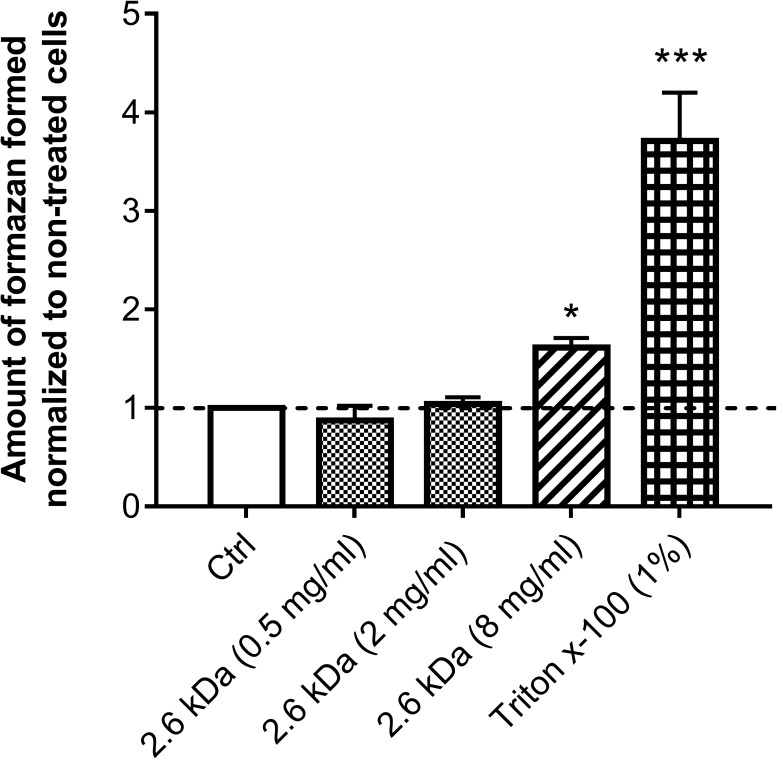
Effect of the 2.6 kDa chitosan on LDH release from MAC-T bovine mammary epithelial cells.Cells were exposed to the 2.6 kDa chitosan at different concentrations (0.5 mg/ml, 2 mg/ml and 8 mg/ml). Triton x-100 and culture medium were used as cytotoxic positive and negative (Ctrl) controls, respectively. The amount of formazan formed was normalized to the amount formed by the non-treated cells (Ctrl). Bars represent the means and vertical lines the standard deviation (SD). Significant differences in comparison to the negative control (Ctrl) are shown. Statistical analysis was performed using the Kruskal-Wallis test (non-parametric one way ANOVA) with Dunn’s multiple comparison test: *, P<0.05; ***, P<0.0001.